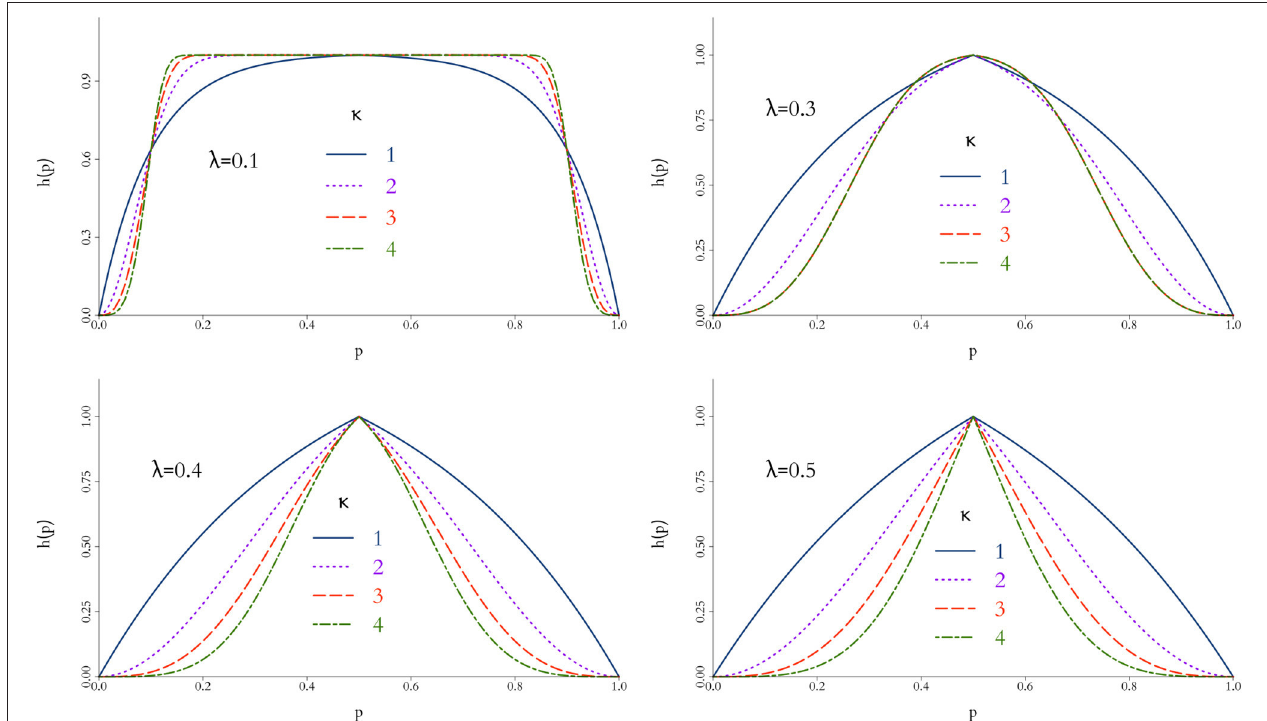
FIGURE 1 | Behaviour of weight function h ( p ) in Equation 10 for different values of λ and κ . The closer h ( p ) to 1, the more compatible the simulations are to the physical data and a larger virtual cohort is used in the combined trial. In general, h ( p ) is rather insensitive for small values of λ and more discriminatory as κ